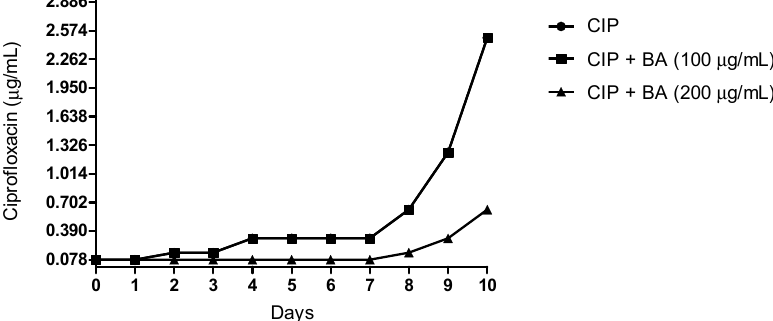
Figure 7. Effects of betulinic acid on the drug tolerance induced by ciprofloxacin. CIP—ciprofloxacin; BA—betulinic acid. S. aureus ATCC 6538 was successively grown in the presence of sub-minimal inhibitory concentration (MICs) of ciprofloxacin and BA (200 µ g / mL or 100 µ g / mL) and after each cycle, the MIC for ciprofloxacin was determined.